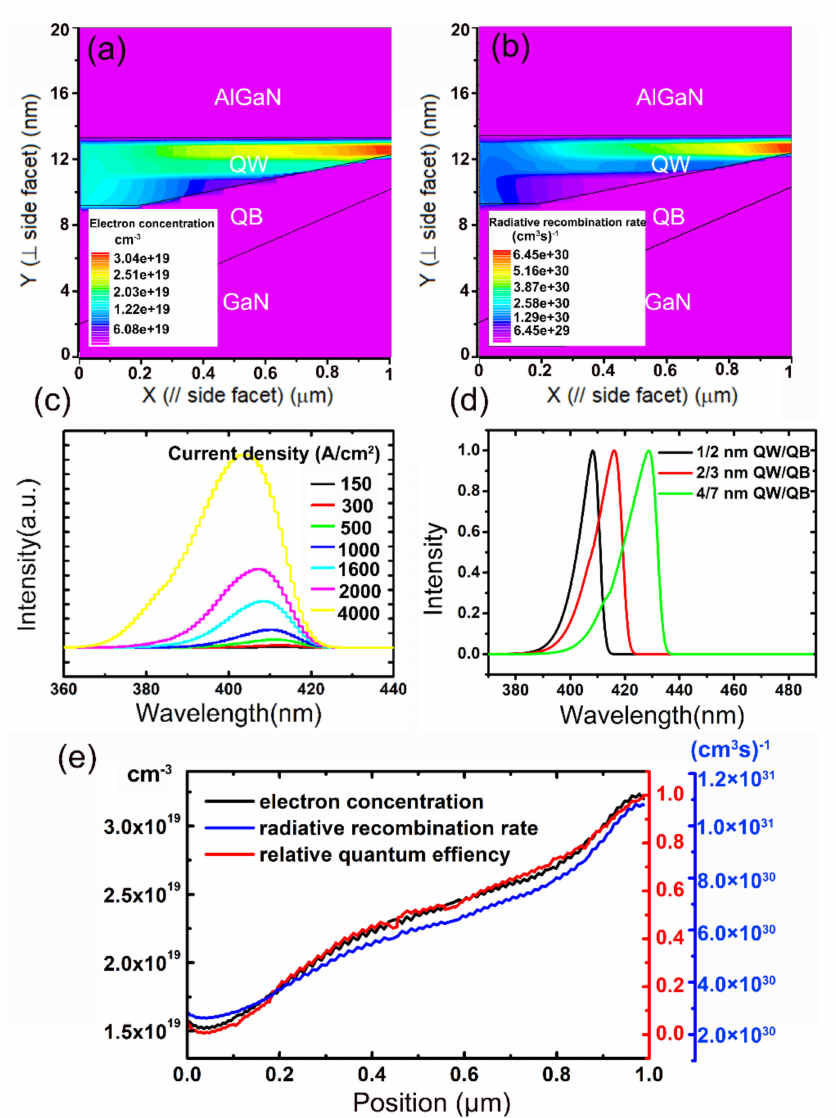
Figure 6. The schematic structure and the spatially resolved distribution of the electron concentration ( a ) and the radiative recombination rate ( b ) inside the QW region at an applied bias of 1600 A/cm 2 . The x axis and y axis stand for the directions parallel and perpendicular to the µ -LED sidewall, respectively. Simulated emission spectra of the µ -LED at a series of injection currents ( c ) and normalized spectra of the LED with uniform In content and QW/QB thickness, as denoted by the labels ( d ). Spatially resolved electron concentration, radiative recombination rate, and relative quantum efficiency in the QW ( e